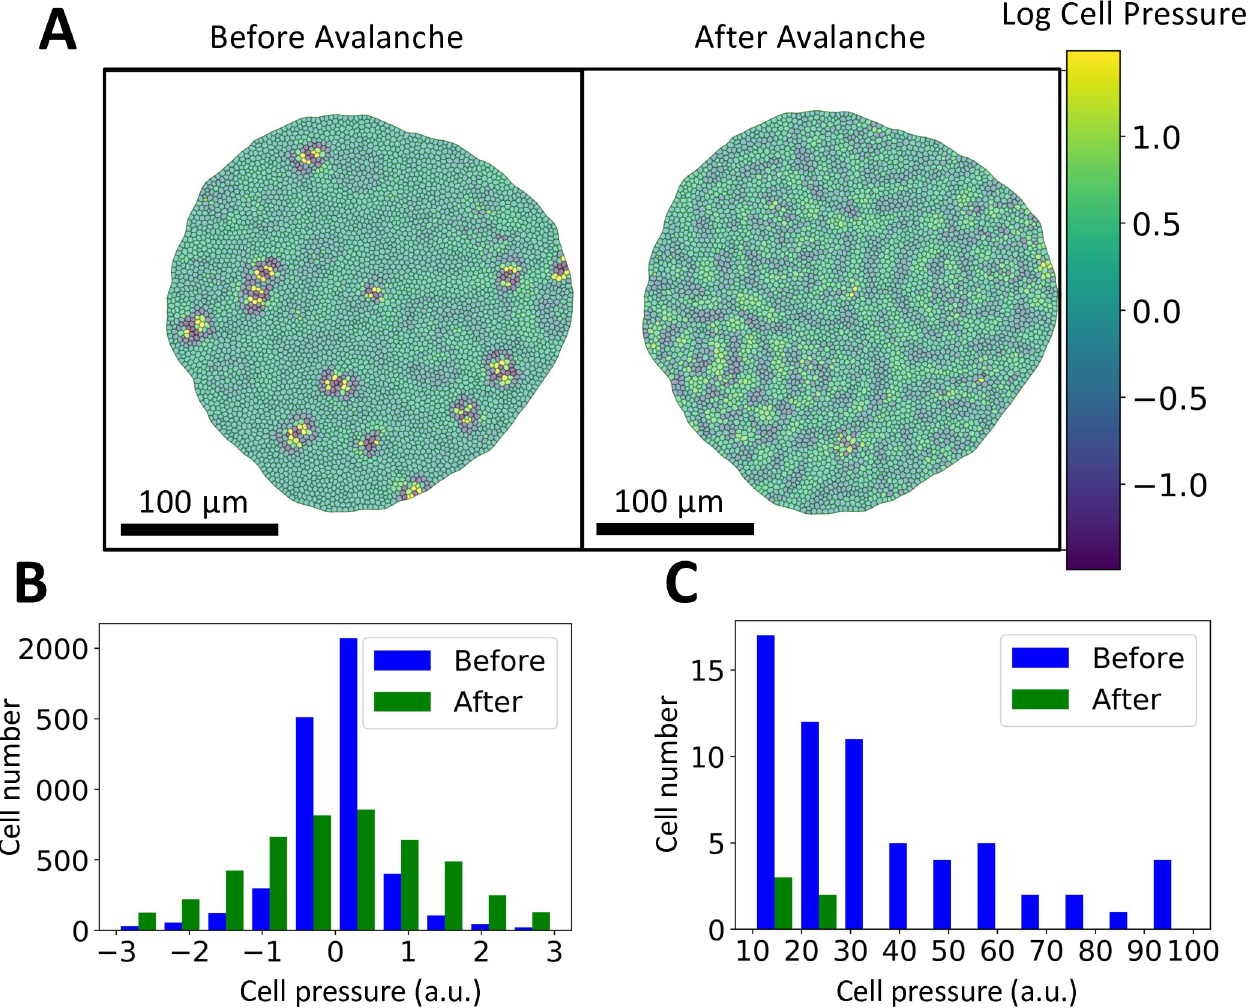
Fig 3. Cellular pressure characteristics during avalanches. A: Cellular pressure profile of the tissue before and after an avalanche, color coded with respect to magnitude. Before the avalanche, high and low pressure regions are localized. After the avalanche, the pressure redistributes across the tissue. B: Frequency histogram of cellular pressure before and after an avalanche. The histogram captures that the majority of cells have low pressure before the avalanche. Furthermore, the widening of the histogram captures the redistribution of pressure after the avalanche. C: Frequency histogram of cellular pressure before and after an avalanche for high pressure ranges. This histogram captures that, before the avalanche, there are hundreds of outlier cells with very high pressure which are not present after the avalanche.